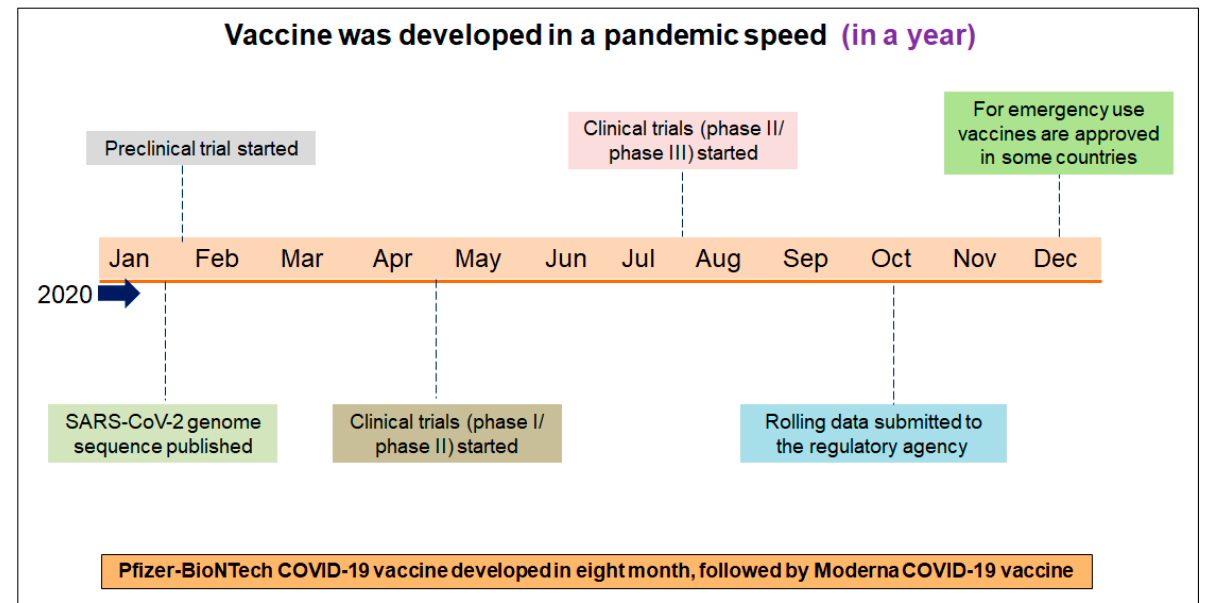
Figure 2. The different significant achievements of the first vaccine’s development and its approval process. The first vaccine (Pfizer–BioNTech mRNA) was developed within eight months. Several researchers call the speed of vaccine development “pandemic speed.” However, previous research has helped to gain knowledge on SARS and MERS, and aided in the process of vaccine development against SARS-CoV-2. Researchers have been focusing on these two coronaviruses for years [50].